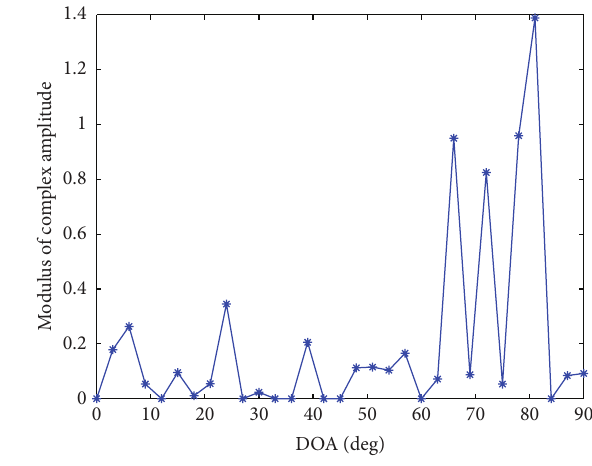
Figure 7: The original scene.